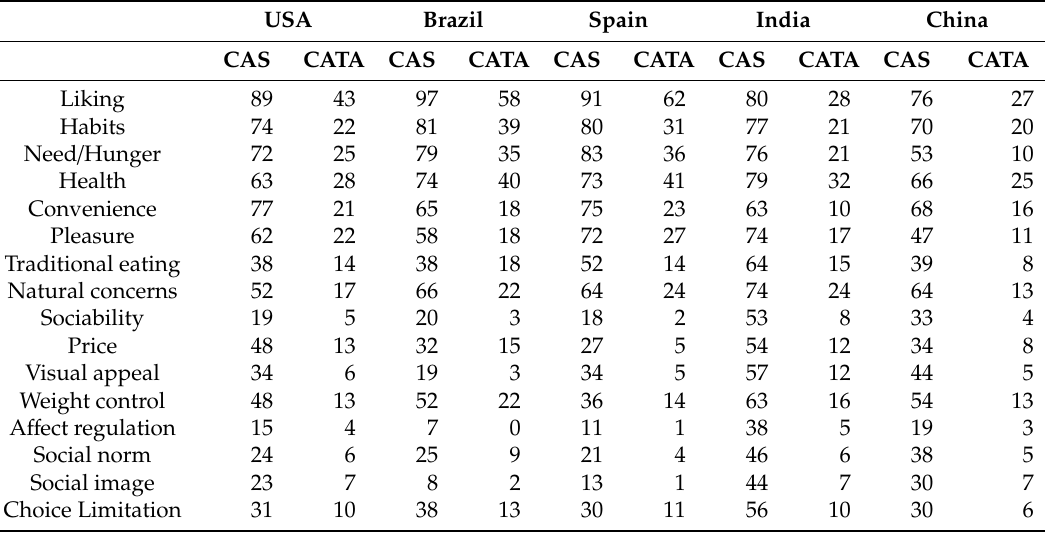
Table A3. Percentage of “agree” responses for CAS and CATA for all five countries for fruit.